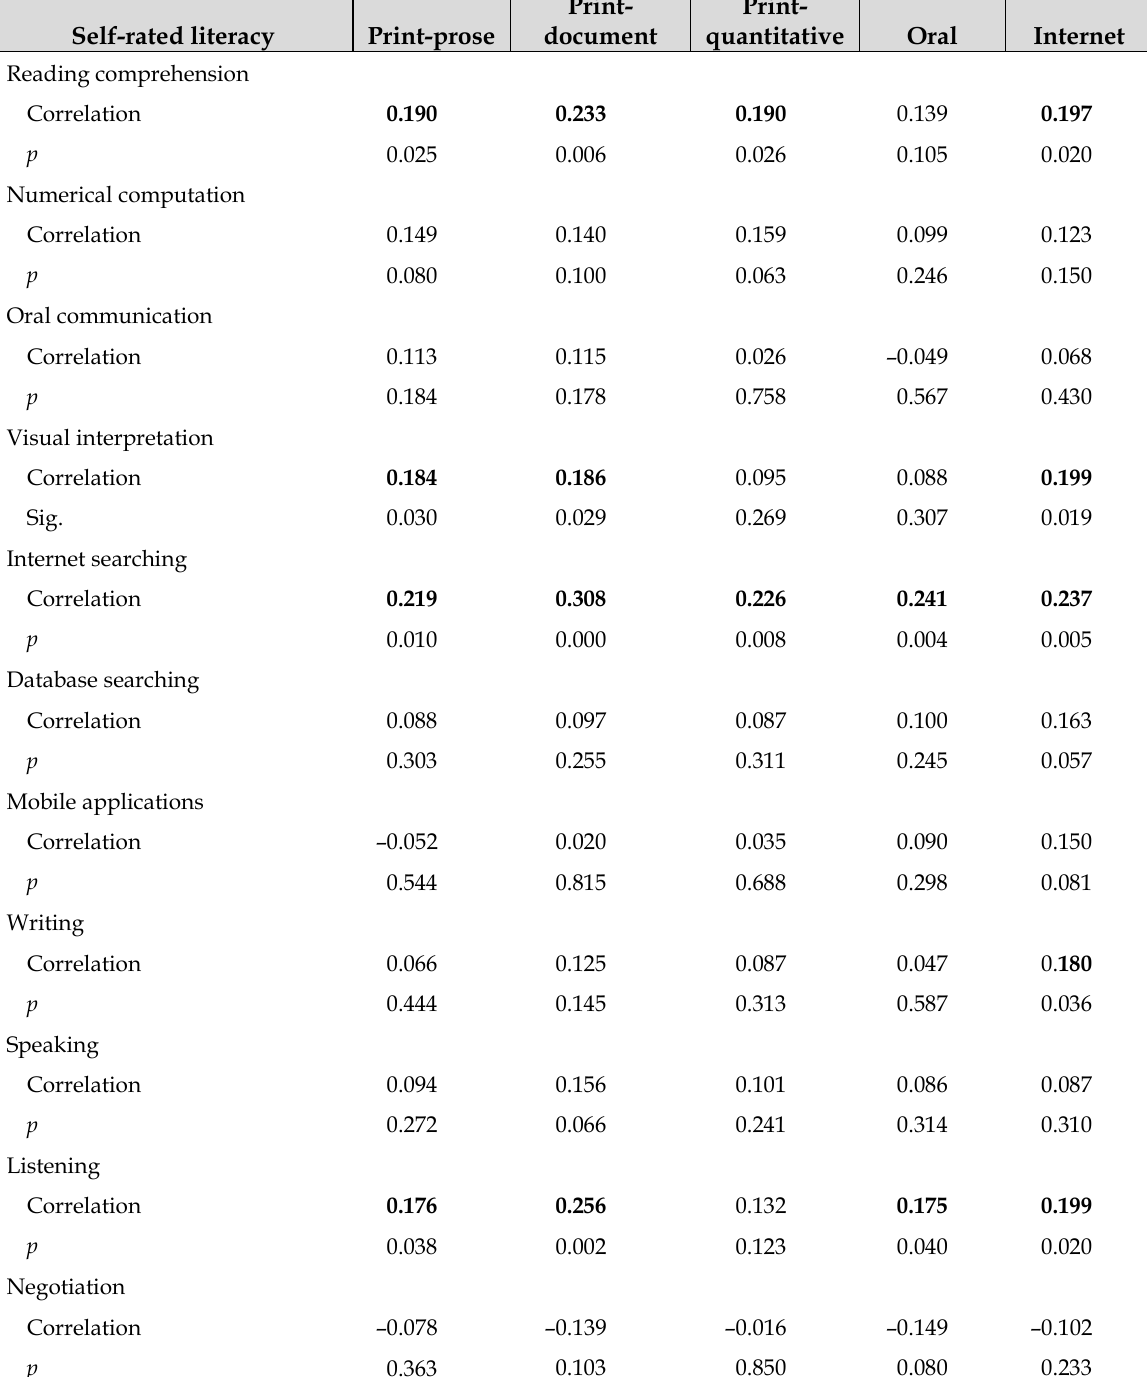
Table 5 Correlations between self-rated and RTI health literacy test subscale scores Self-rated